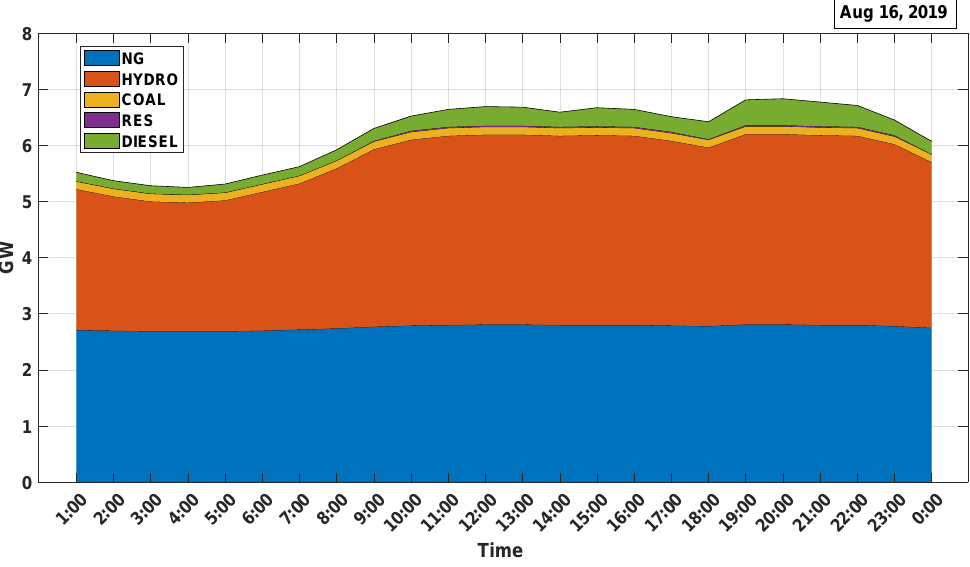
Figure 9. Contribution to the dispatch of the electrical system—stage